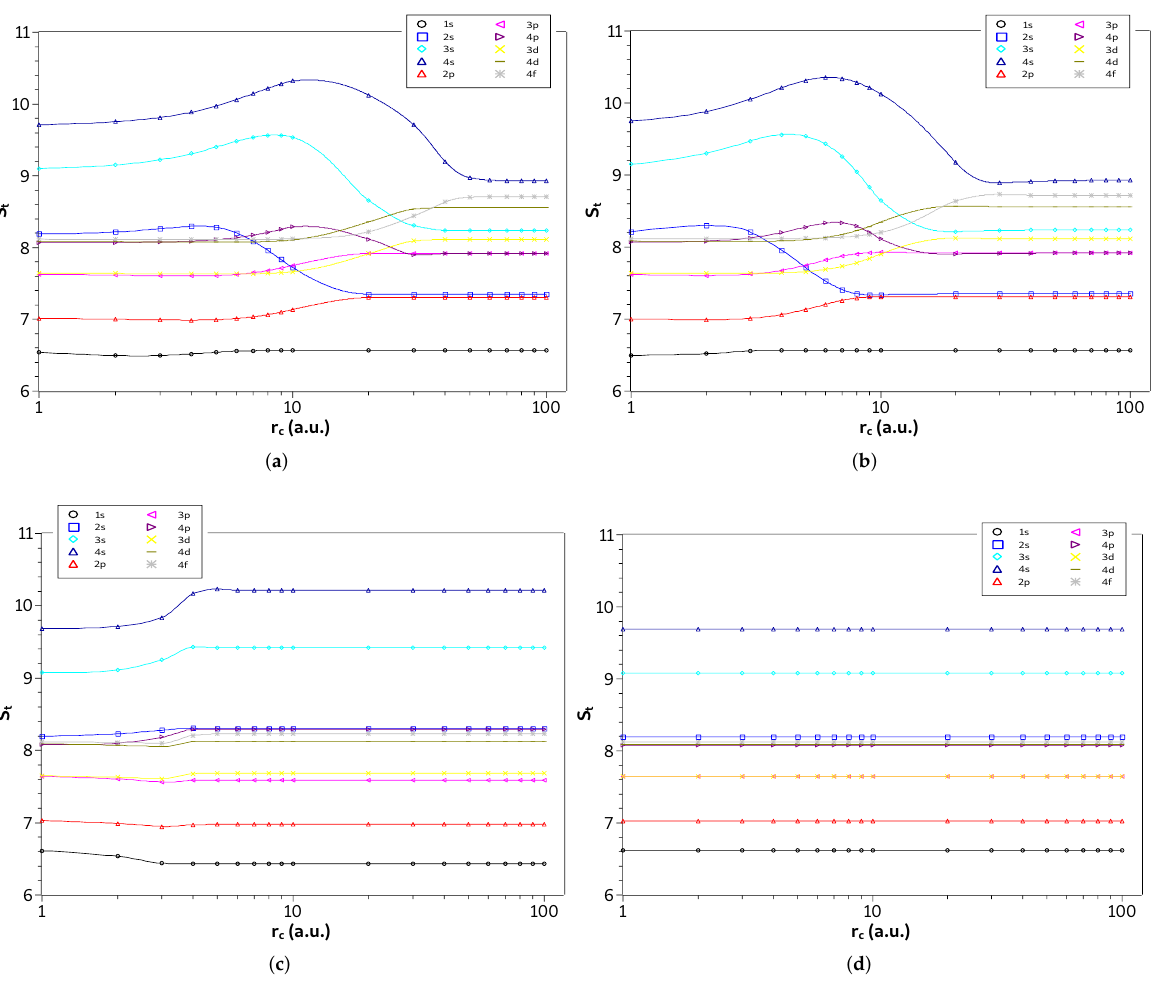
Figure 5. Values of S t in different quantum states as a function of r c on a logarithmic scale in the weak and intermediate regions for the ( a ) hydrogen confined, ( b ) ion-sphere, ( c ) confined harmonic oscillator, and ( d ) particle confined in a